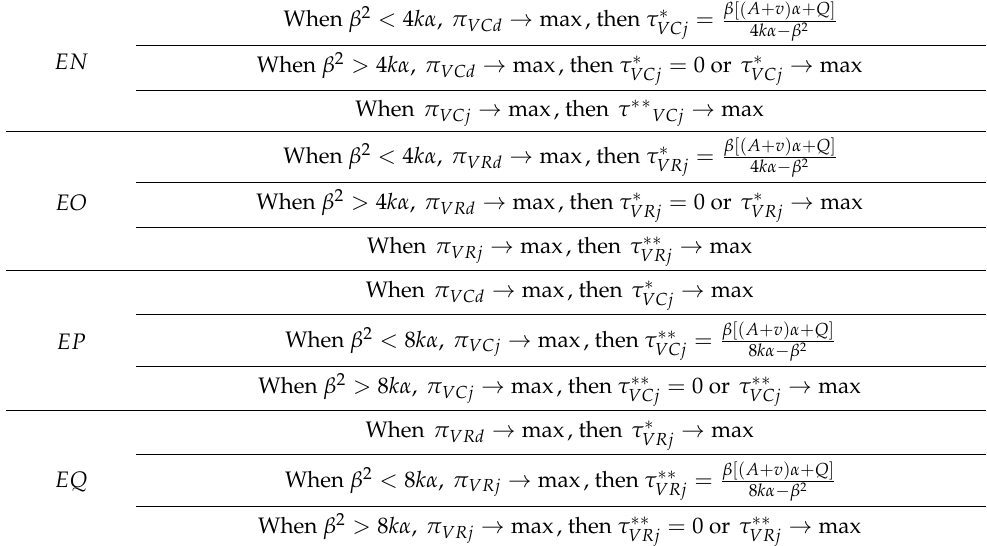
Table 2. Optimal